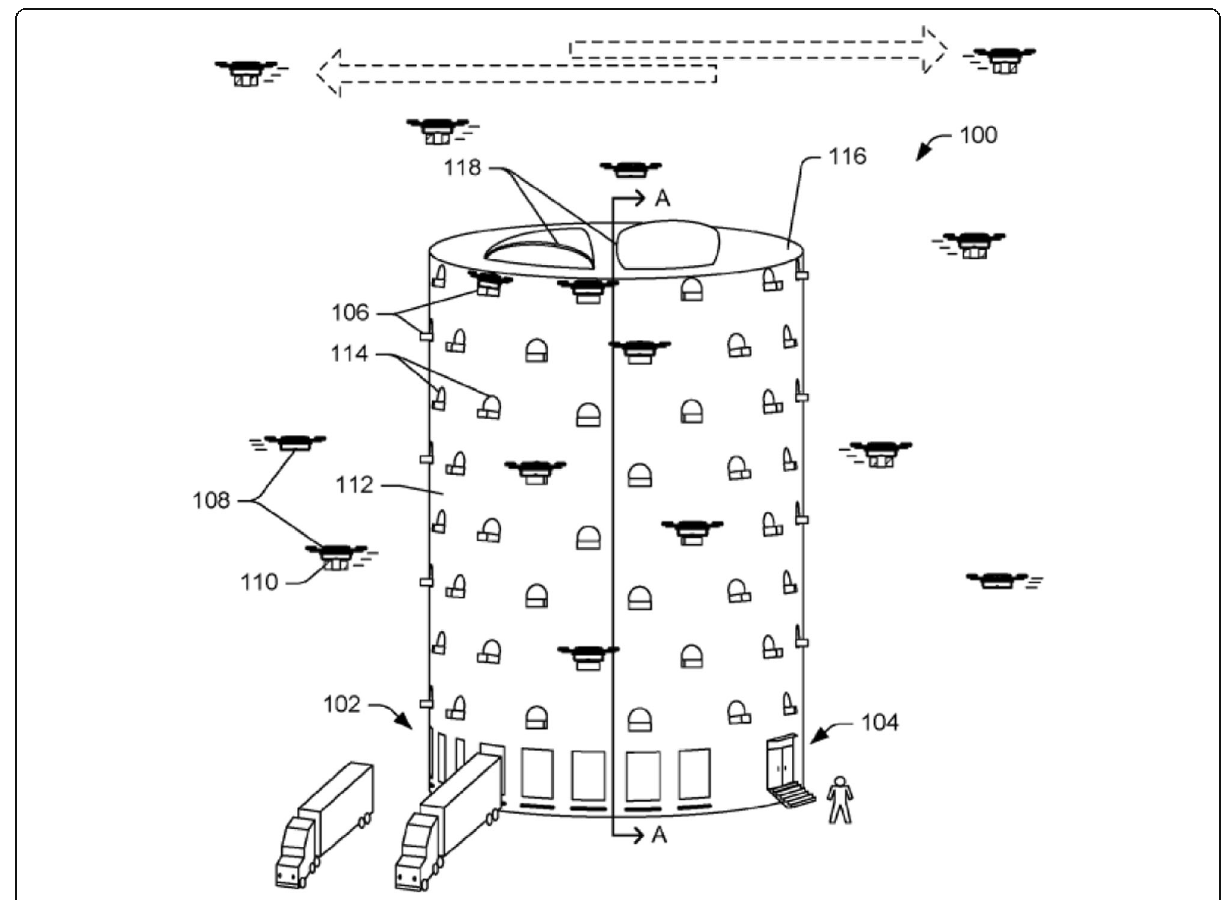
Fig. 1 Amazon drone-beehive concept (source: Curnlander et al., 2017)